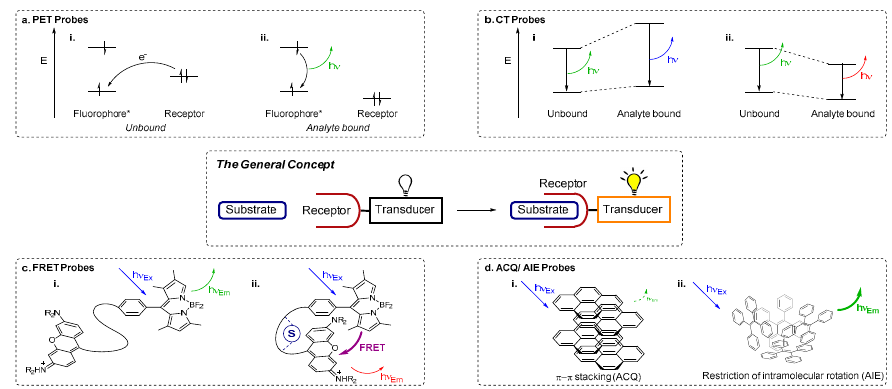
Figure 1. Schematic representation of a receptor-substrate interaction transduced into a detectable signal (central panel) and the key concepts underpinning important mechanisms of fluorescence sensing. ( a ) Photoinduced Electron Transfer (PET) : frontier orbital energy diagrams showing how (i) PET from the receptor quenches the fluorescence output of the fluorophore (the transducer); but (ii) when the substrate/analyte binds to the receptor, PET is inhibited and fluorescence emission turned on; ( b ) Charge Transfer (CT) : frontier orbital diagrams representing the energy levels of CT systems and changes in emission wavelength due to (i) a reduced dipole moment (blue-shifted fluorescence emission) and (ii) an enhanced dipole moment (red-shifted fluorescence emission); ( c ) Förster Resonance Energy Transfer (FRET) : (i) two π systems that are too far apart for FRET to occur in the absence of substrate; are (ii) brought into proximity when the substrate (S) binds, enabling the FRET process and triggering a change in the emission wavelength; ( d ) Aggregation Caused Quenching (ACQ) and Aggregation Induced Emission (AIE) : schematic representations of (i) ACQ resulting from the stacking of pyrene units and (ii) AIE that occurs when the ‘rotors’ of hexaphenylsilole (HPS) interlock. See text for further discussion of these sensing mechanisms.